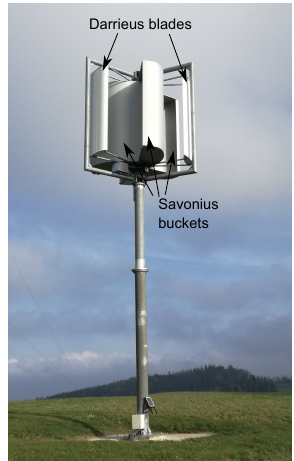
Figure 2. Vertical wind turbine with hybrid rotor configuration Savonius–Darrieus.